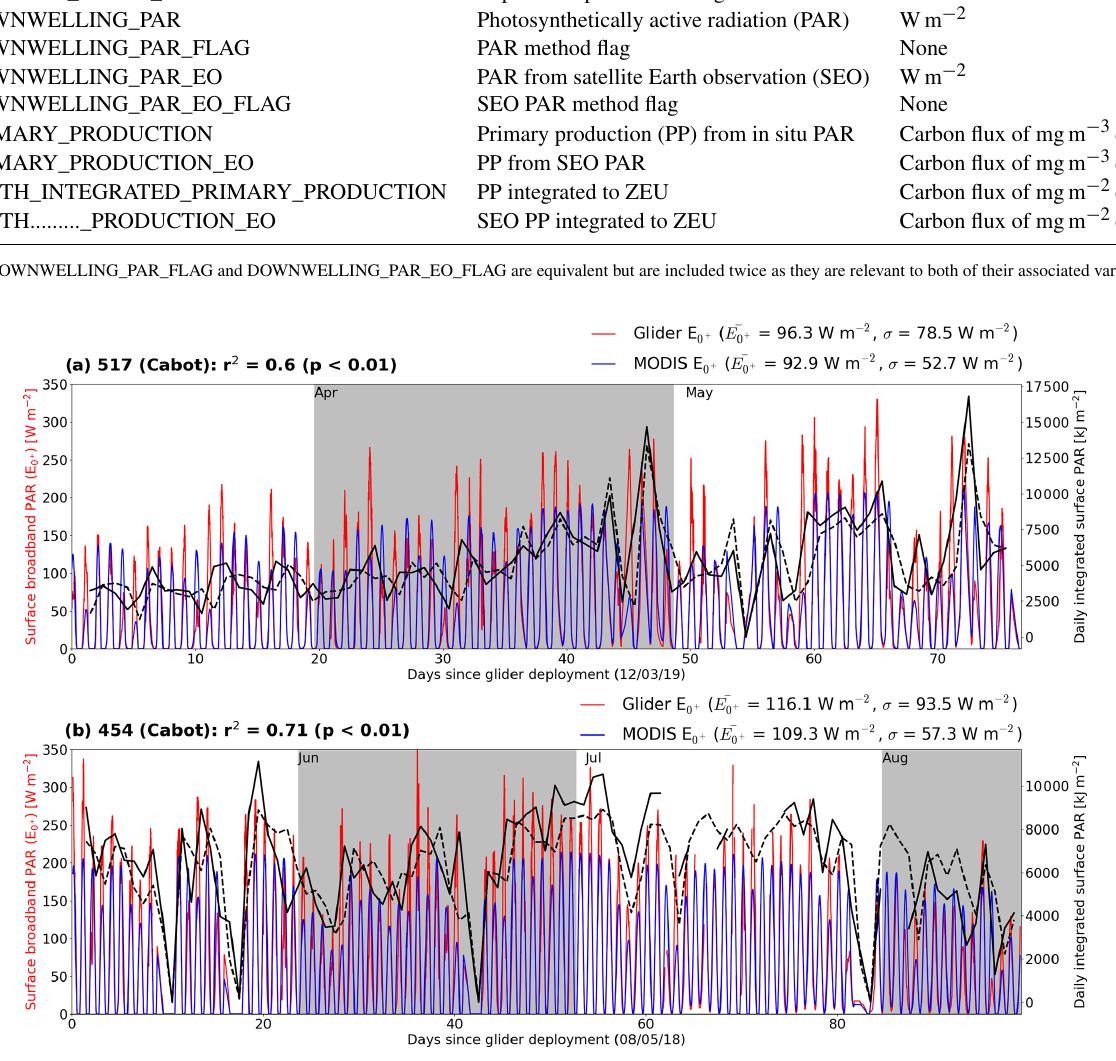
Figure 4. Comparison of glider- and MODIS-based surface broadband PAR (E0 + ) values. Red and blue traces show the 10-profile smoothed PAR for the glider and interpolated MODIS products, respectively. These are recorded against the left-hand axis. All statistics ( r 2 , µ , σ ) are based on the valid, unsmoothed time series data for daytime profiles only. The solid and dashed black traces, measured against the right-hand axis, show the daily integrated PAR values for the glider and MODIS products, respectively, and are derived from the corresponding red and blue